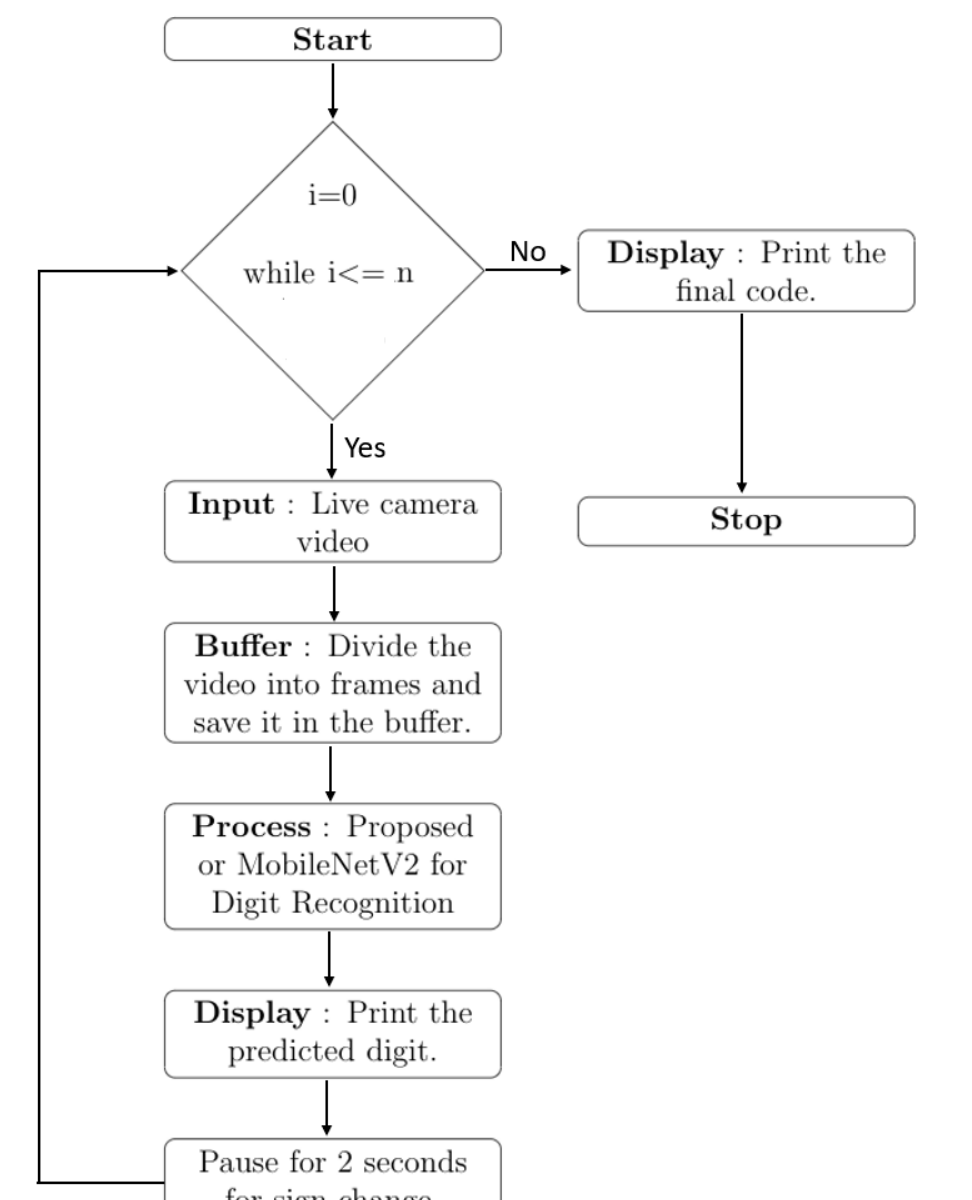
Figure 7. Workflow diagram for the contactless authentication code generation. Note that ‘n’ is the length of the code (n = 4